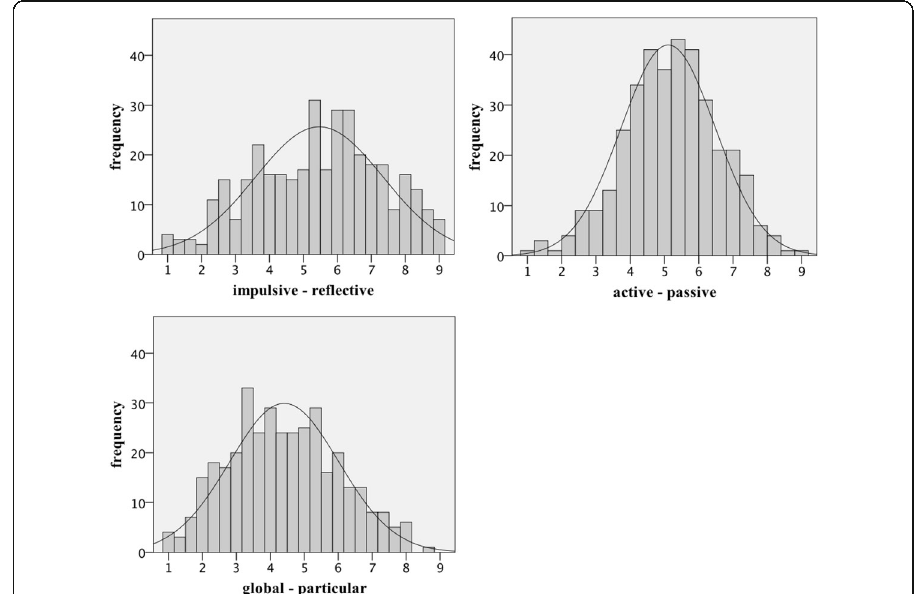
Fig. 1 Histograms of the three extracted